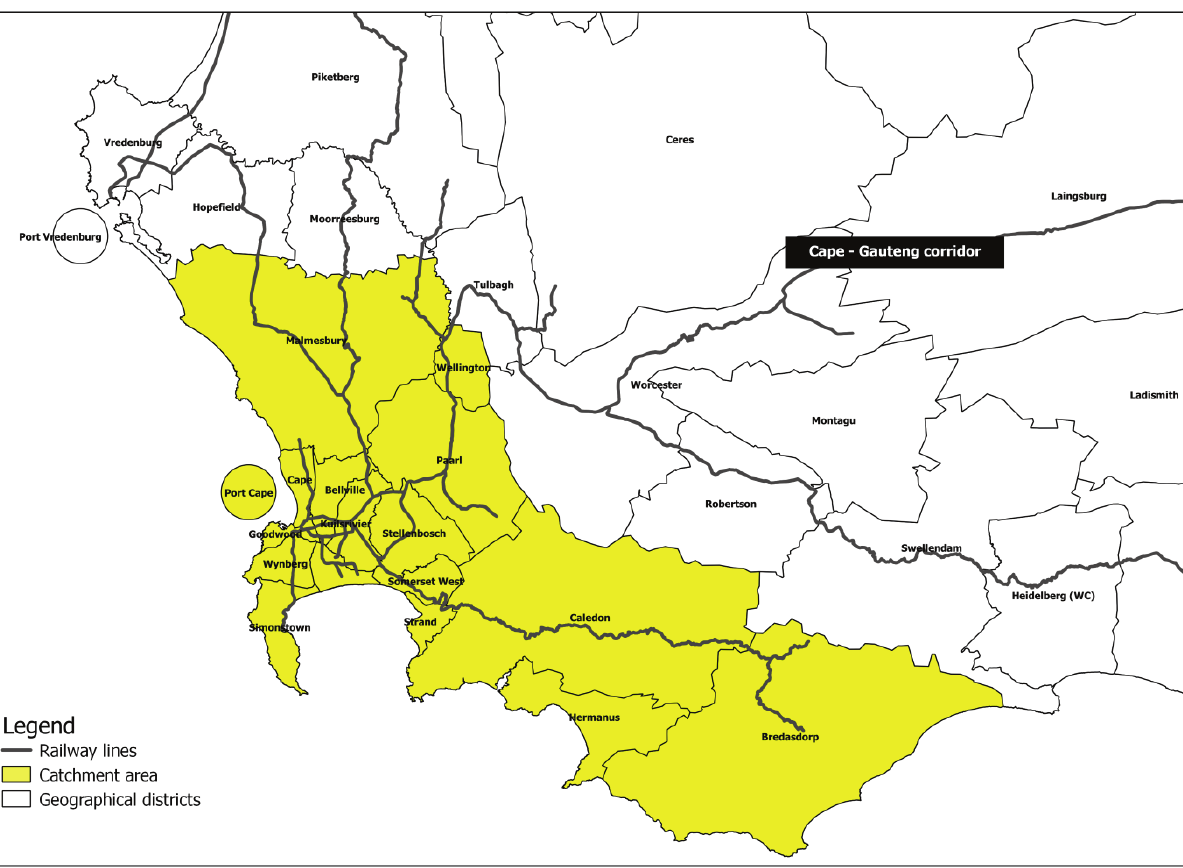
Figure 1: Catchment area for proposed IICT Table 1: Segmented container freight